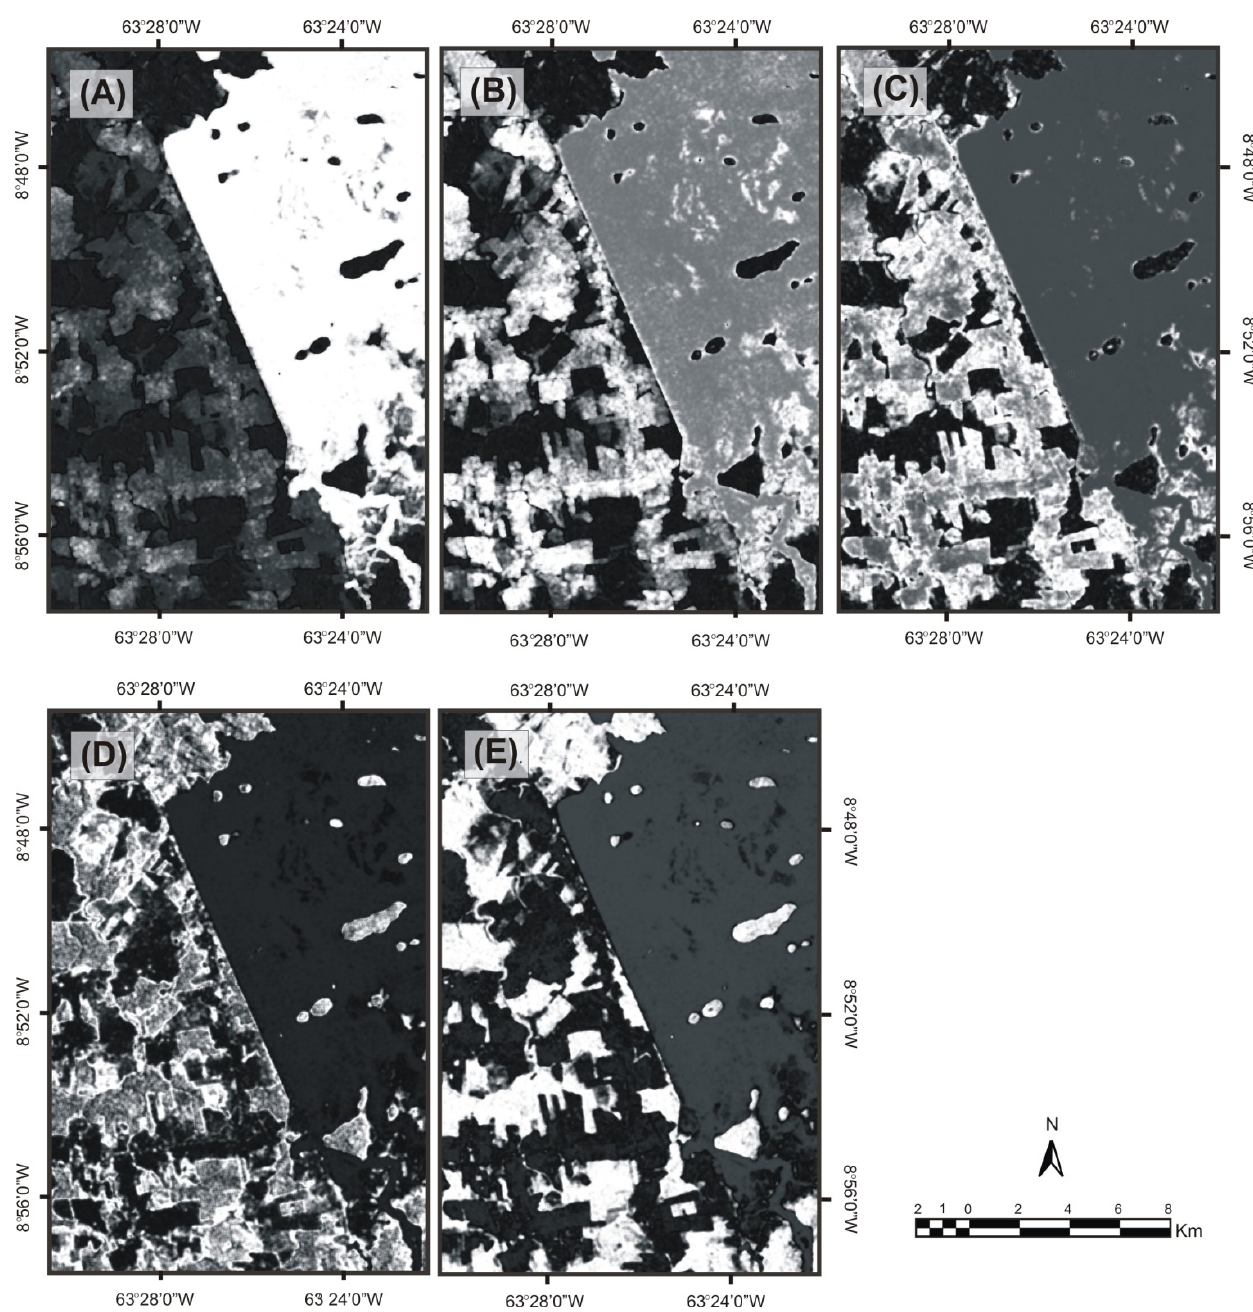
Figure 13. Rule images of the Spectral Correlation Mapper (SCM) method, considering the endmembers of Figure 10: ( A ) Curve A; ( B ) Curve B; ( C ) Curve C; ( D ) Curve D; and ( E ) Curve